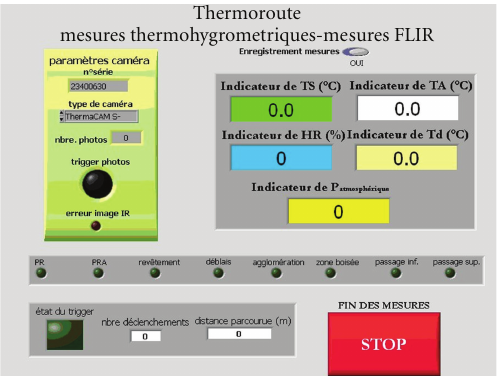
Figure 3: Software interface for data acquisition with atmospheric and infrared